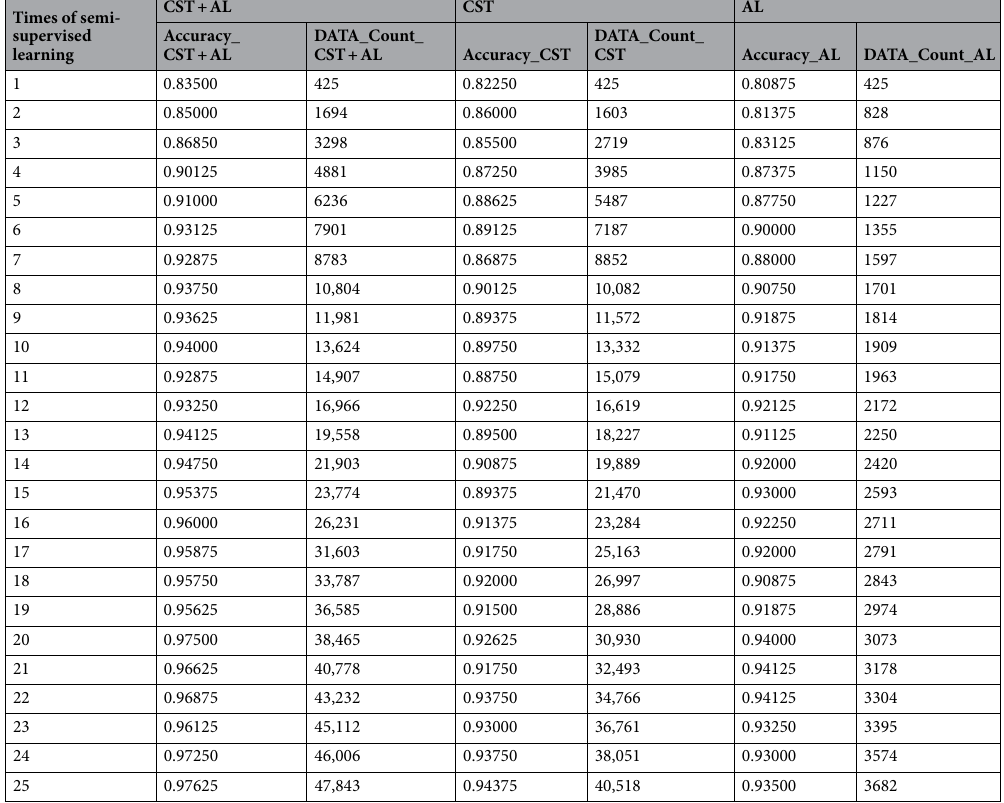
Table 1. Added data counts and accuracies after each iteration of semi-supervised